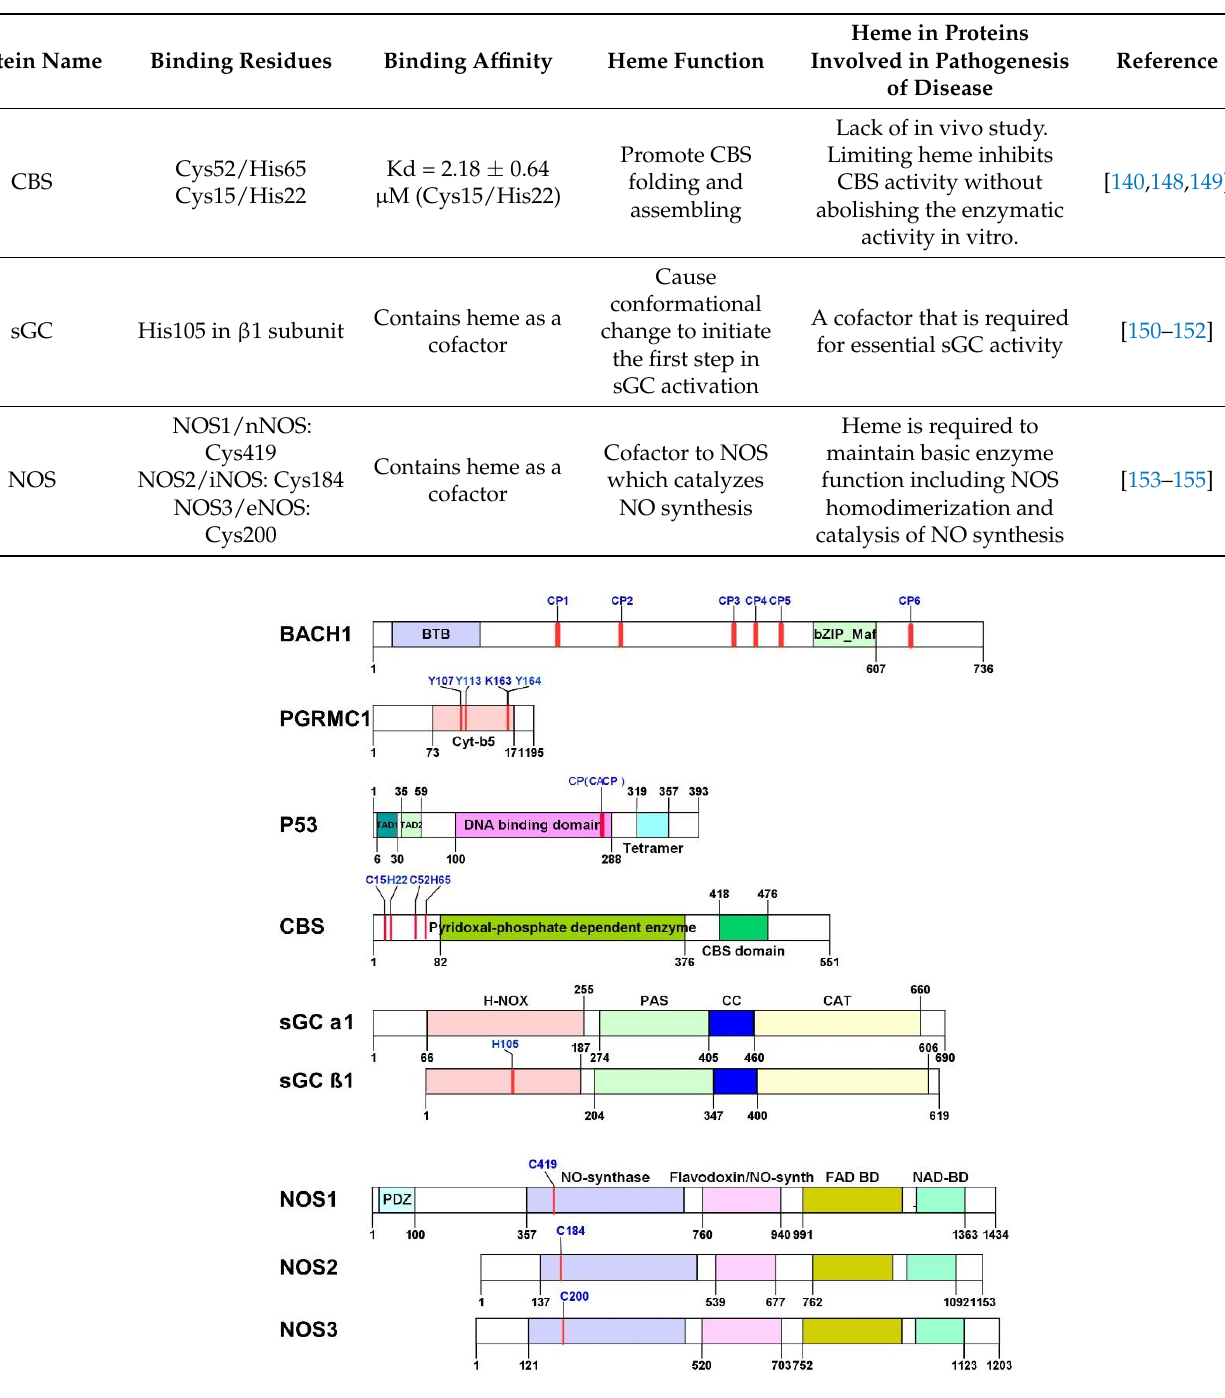
Figure 2. The domain structure of heme regulated signal transducers and regulators. Red lines represent the location of heme-binding sites. BACH1: BTB domain (Broad-Complex, Tramtrack and Bric a brac), bZIP_Maf domain (Basic leucine zipper domain, Maf-type). PGRMC1: